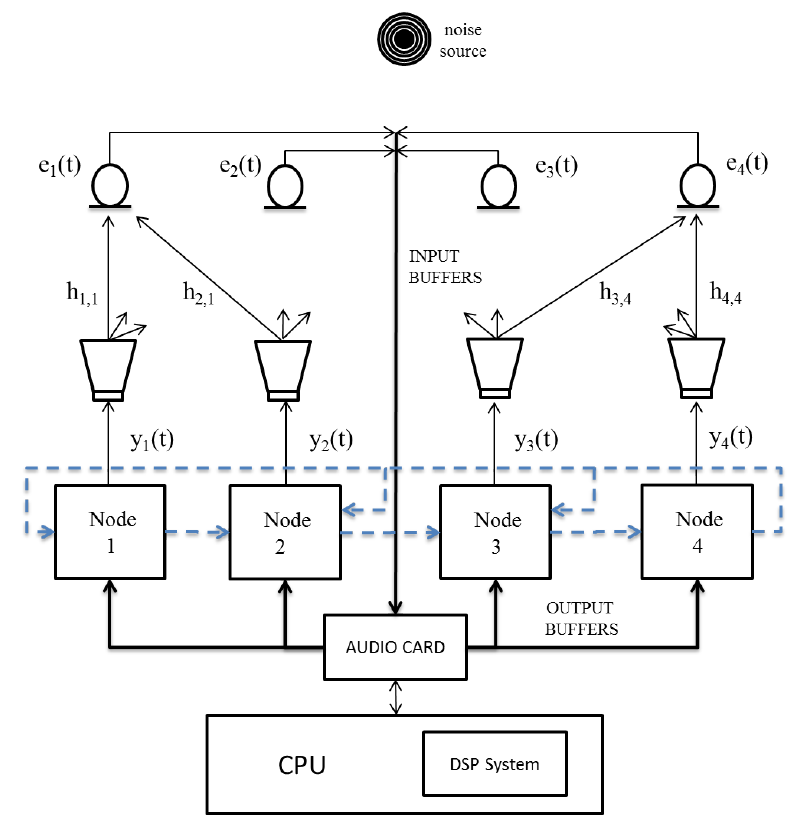
Figure 5. Scheme of the ANC prototype. The incremental communication strategy is represented by dashed